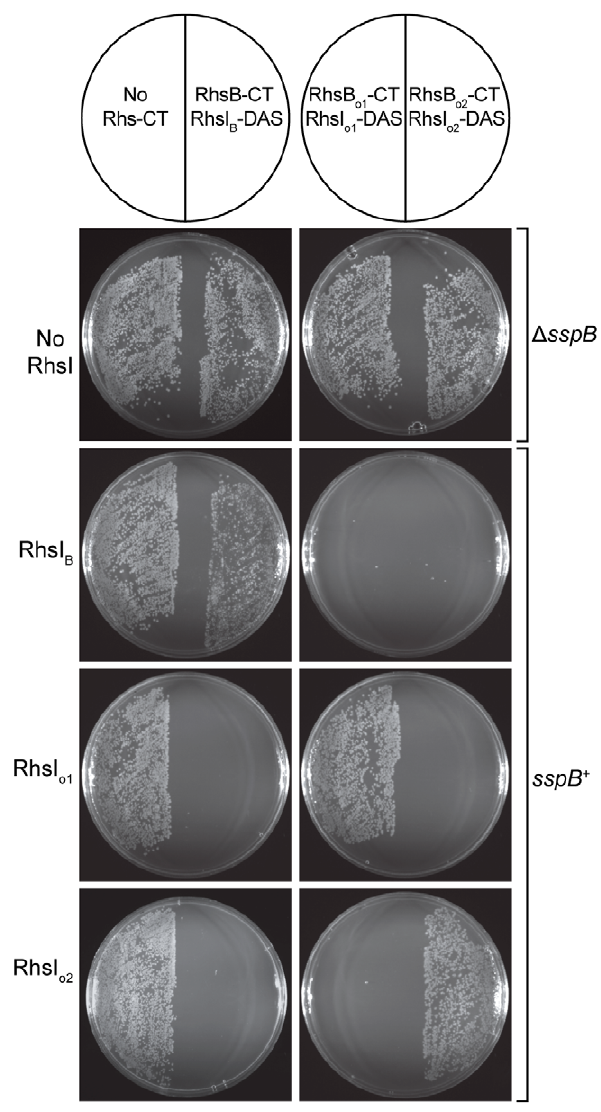
Figure 10. The Rhs genes of D. dadantii 3937 encode toxin/ immunity pairs. E. coli sspB + cells expressing RhsI 3937 proteins were incubated with supercoiled plasmids encoding the various Rhs-CT 3937 / RhsI 3937 -DAS pairs and plated to select stable transformants. All Rhs- CT 3937 /RhsI 3937 -DAS constructs were also introduced into E. coli D sspB cells to demonstrate that RhsI 3937 -DAS degradation is required for growth inhibition.